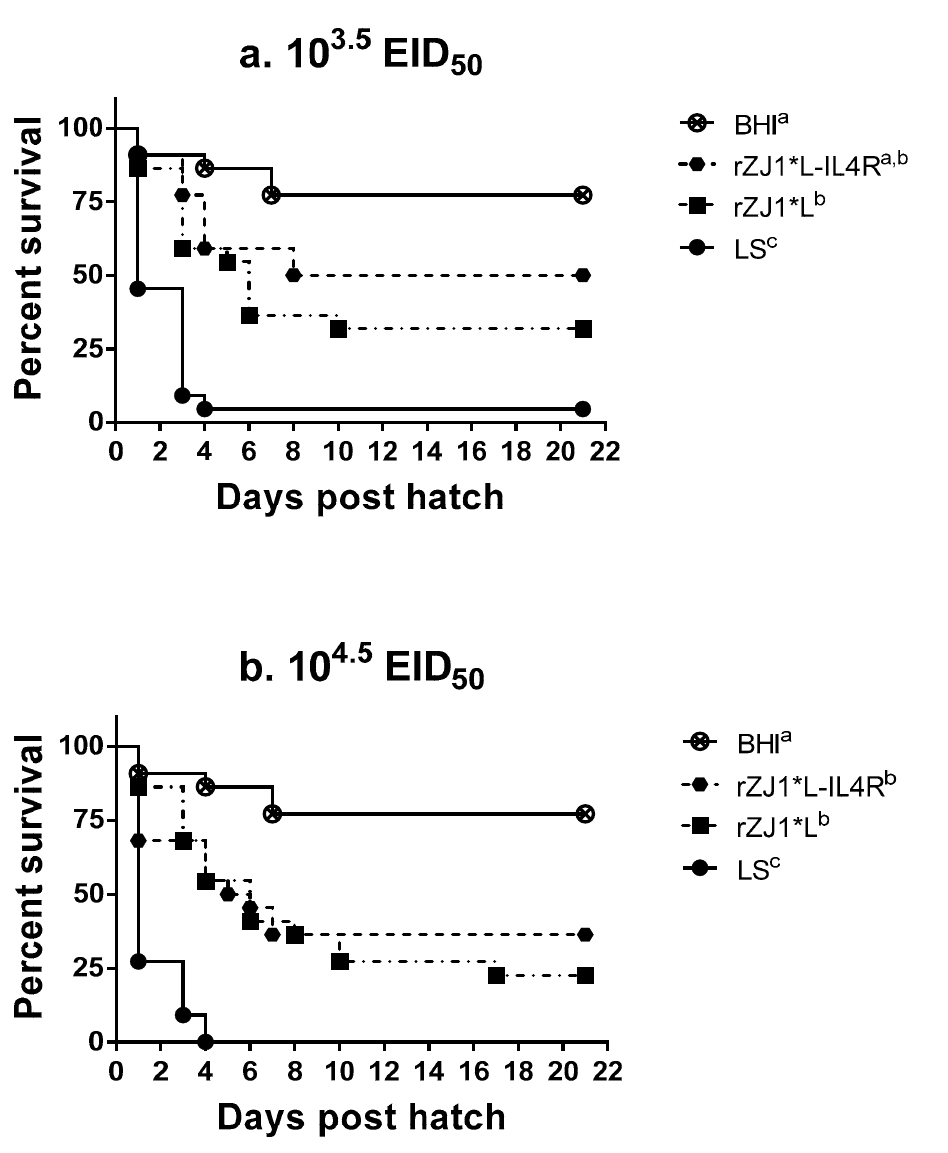
Figure 2. Effect of rZJ1*L-IL4R vaccination at 18 DOE on post-hatch survival. At 18 DOE, SPF embryonated chicken eggs ( n = 22) were vaccinated in ovo with ( a ) 10 3.5 EID 50 /egg or ( b ) 10 4.5 EID 50 /egg of rZJ1*L-IL4R, rZJ1*L, LS, or brain heart infusion (BHI) control. Post-hatch, chickens were housed in negative pressure isolators and their survival was checked daily for 21 days. The survival curves were analyzed using the Log-rank test ( p ≤ 0.05). Groups with different letters are significantly different. Antibody responses were evaluated by performing HI assays. Chickens that were vaccinated with 10 3.5 EID 50 of rZJ1*L-IL4R had mean pre-challenge HI titers of 7.5 ± 0.53 (log 2 ± SEM), these were significantly lower than those from chickens vaccinated with rZJ1*L 10 3.5 EID 50 , which had HI titers of 9.0 ± 0.45 ( p ≤ 0.05) (Figure 3). Pre-challenge, chickens vaccinated with 10 4.5 EID 50 of rZJ1*L-IL4R had mean HI titers of 8.5 ± 0.42, which were significantly higher than those from chickens vaccinated with rZJ1*L 10 4.5 EID 50 (6.6 ± 0.24, p ≤ 0.05). No significant differences in HI titers were observed between vaccine groups at 14 DPC (Figure 3). The HI titers pre- and post- vNDV challenge were not significantly different within each vaccine group ( p ≤